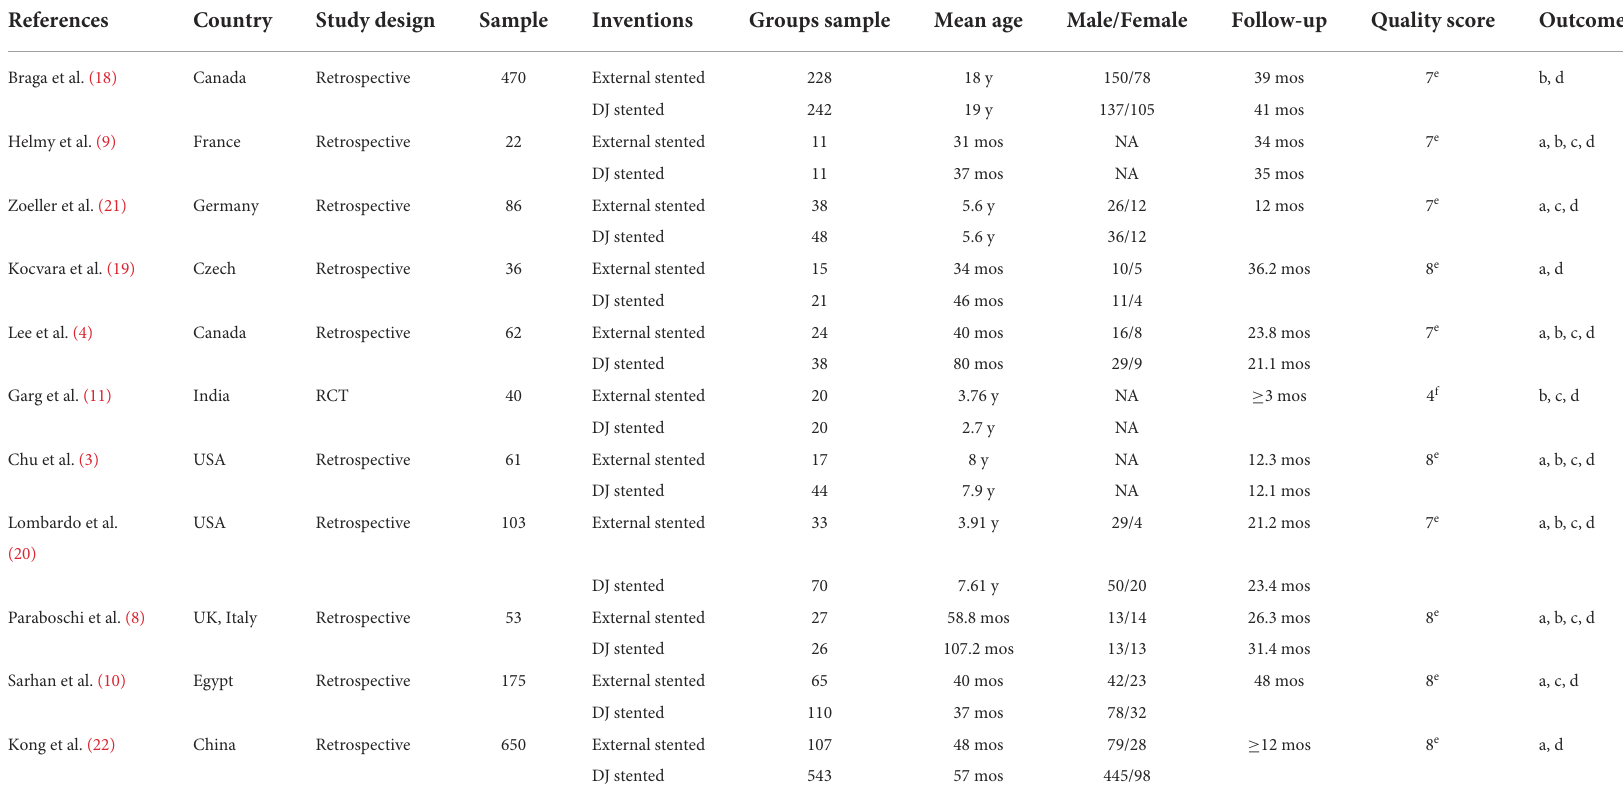
TABLE 1 Baseline characteristic of included